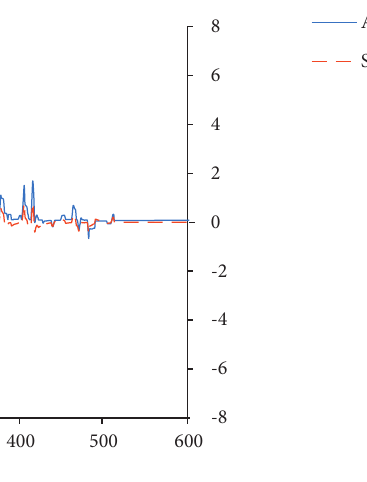
Figure 9. Comparison between the airplane and the SIVOR cockpit roll